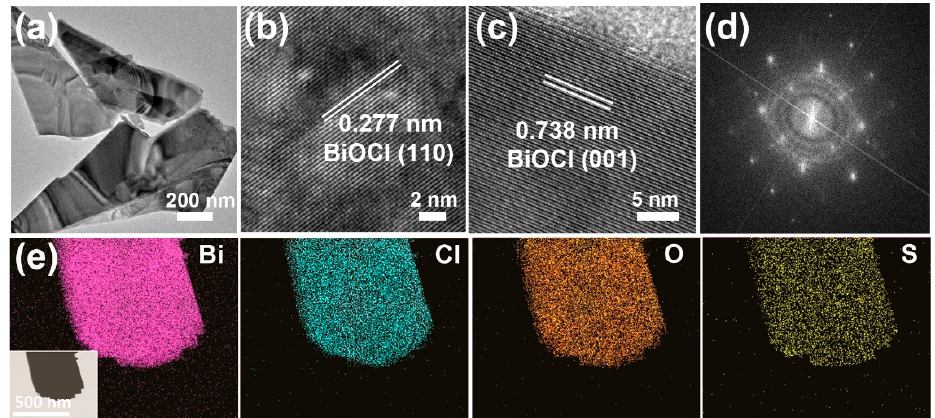
Figure 1. SEM images of ( a ) commercial BiOCl and ( b ) S-BiOCl. Scale bar: 1 µ m. ( c ) XRD patterns and ( d ) partial amplified XRD patterns of commercial BiOCl and S-BiOCl.